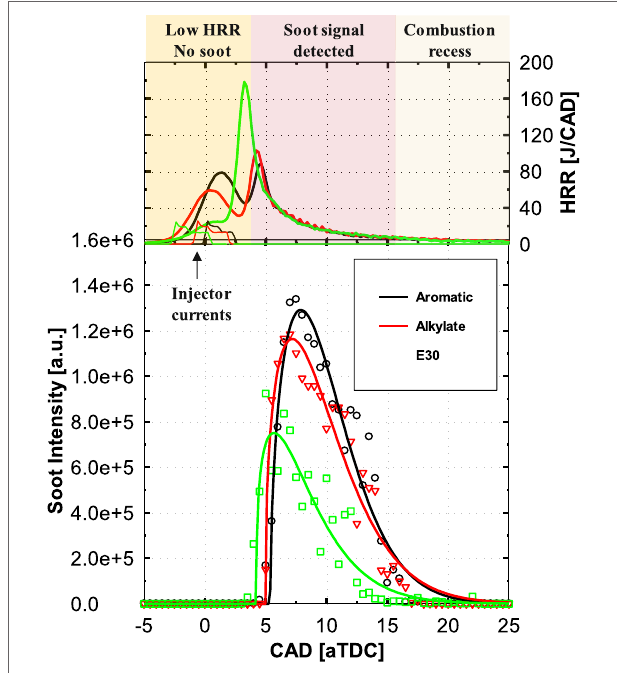
FigUre 9 | Comparison of heat release rate (HRR) and soot intensity profiles for three fuels at exhaust gas recirculating (EGR) = 25%, λ = 1.8.